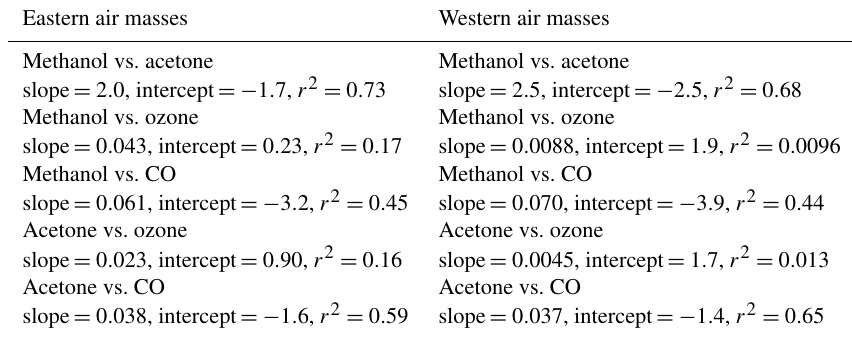
Table 2. Slope, intercept and correlation coefficient ( r 2 ) of different compounds separated in air masses from eastern and western Europe. Eastern air